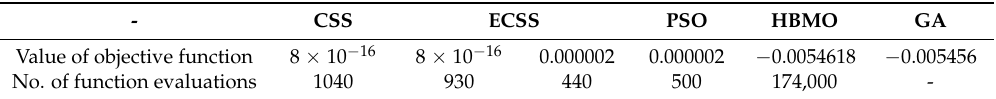
Figure 1. Surface of the Ackley’s function for ( a ) − 30 ≤ x1, x2 ≤ 30 and ( b ) − 2 ≤ x1, x2 ≤ 2. Table 1. Results of the standard Charged System Search (CSS) and Enhanced Charged System Search (ECSS) algorithm, in comparison with the other rival metaheuristics algorithms for Ackley’s function.